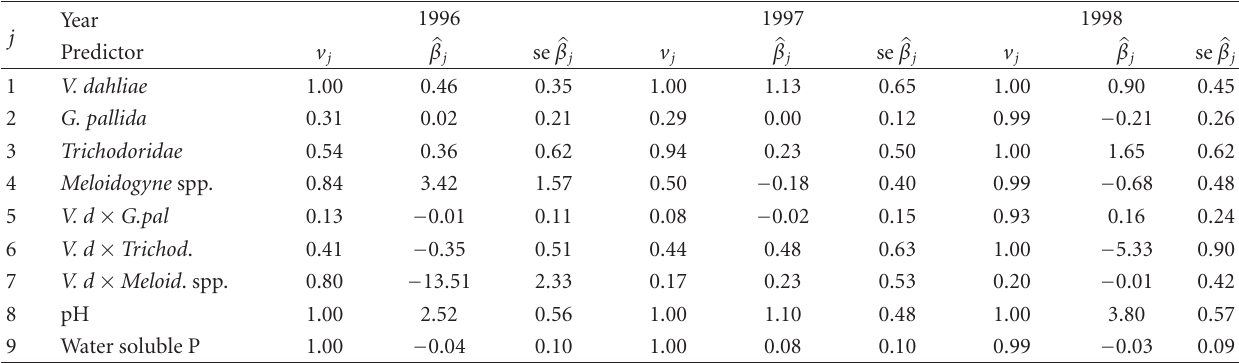
Table 3: Summed weight, v j = Σ wrI j ( r ), weighted regression coe ffi cients, (cid:10) β subterranea in the years 1996, 1997, and 1998. Units: V. dahliae in cfu g − 1 soil; G. pallida , Trichodoridae, and Meloidogyne spp. in mL − 1 and Water soluble P in kg ha − 1 .